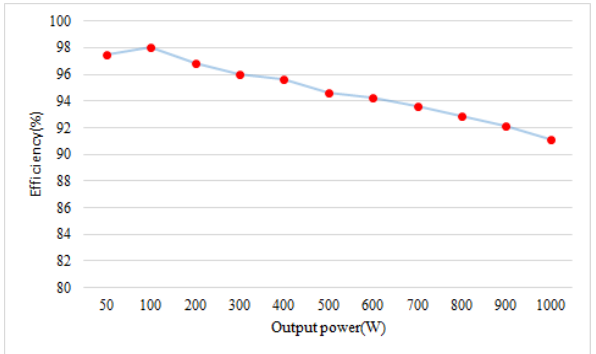
Figure 19. Power conversion efficiency.